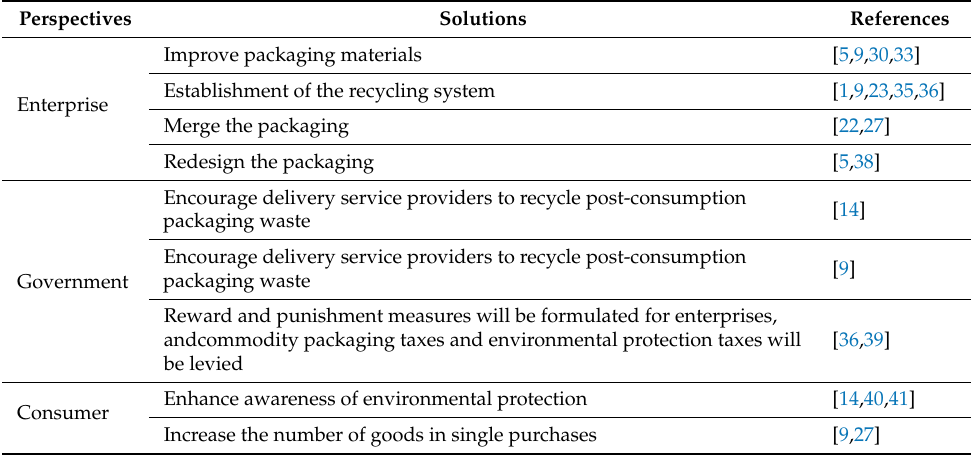
Table 1. E-commerce overpackaging